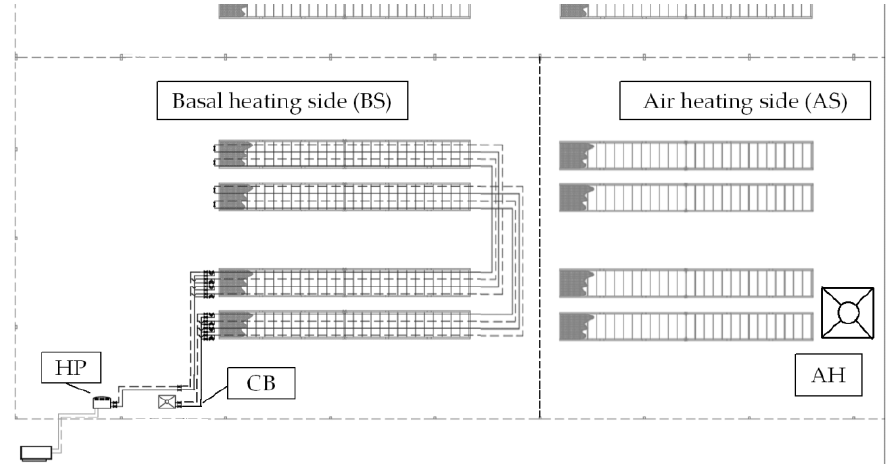
Figure 5. Detailed layout of the experimental trial: in the left part the dashed and full lines represent the pipes used to heat the growth substrate.